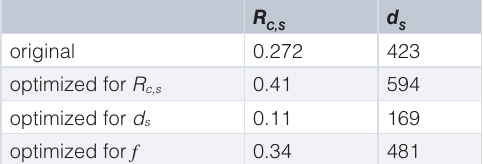
Table 3. Reaction times ( d S ) and response efficiency ( R C,S ) in a biological system and under